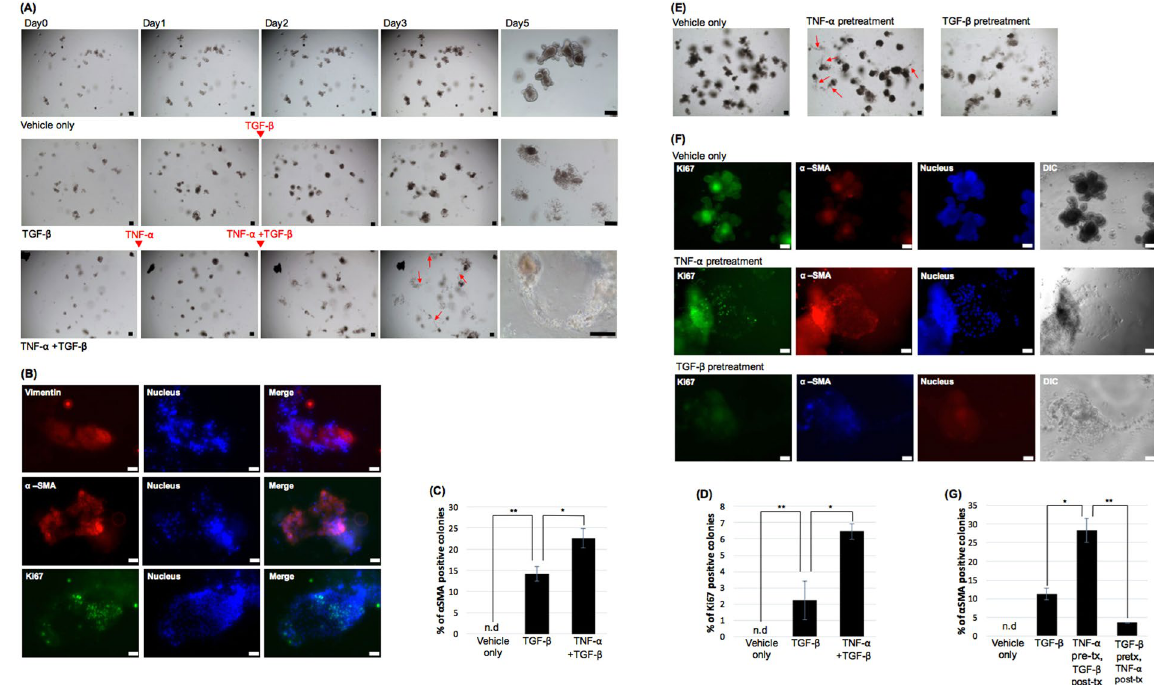
Figure 3. Pretreatment of TNF- α can synergistically induce mesenchymal changes in TGF- β treated IEOs. ( A ) Time-course images of the mesenchymal changes and migratory cells in IEOs treated with TNF- α and TGF- β 1. Bars, 100 μ m. Red arrow, migrating cells. ( B ) The expression of α -SMA and Ki67 was examined in TGF- β and TNF- α treated IEOs. Bars, 50 μ m. ( C ) The percentage of α -SMA positive colonies among all the colonies was determined. ( D ) The percentage of Ki67 positive colonies among all the colonies was determined. ( E ) Images of mesenchymal change when the order of treatment of TNF- α and TGF- β in IEOs was changed. Bars, 100 μ m. Red arrow, migrating cells. ( F ) The expression of α -SMA and Ki67 was examined when the order of treatment of TNF- α and TGF- β in IEOs was changed. Bars, 50 μ m. ( G ) The percentage of α -SMA positive colonies among all the colonies was determined when the order of treatment of TNF- α and TGF- β in IEOs was changed. Data are presented as the mean ± SEM; n = 4 samples per bar, ** p < 0.01, * p < 0.05.